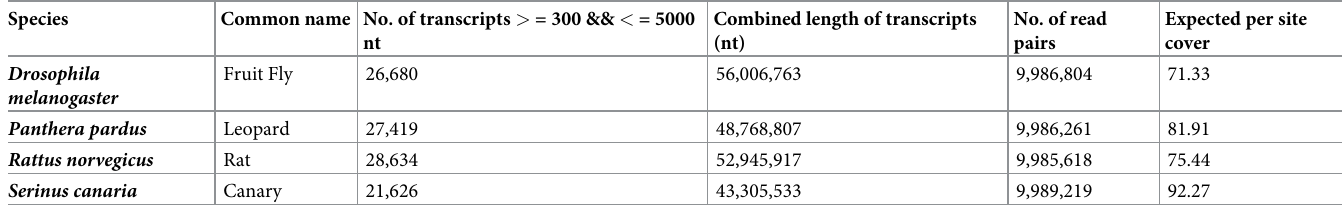
Table 1. Summary of simulated datasets. The cDNA reference sequences (release-100) used as templates for simulation were downloaded from: https://www.ensembl. org/info/data/ftp/index.html. Species Common name No. of transcripts > = 300 && < = 5000